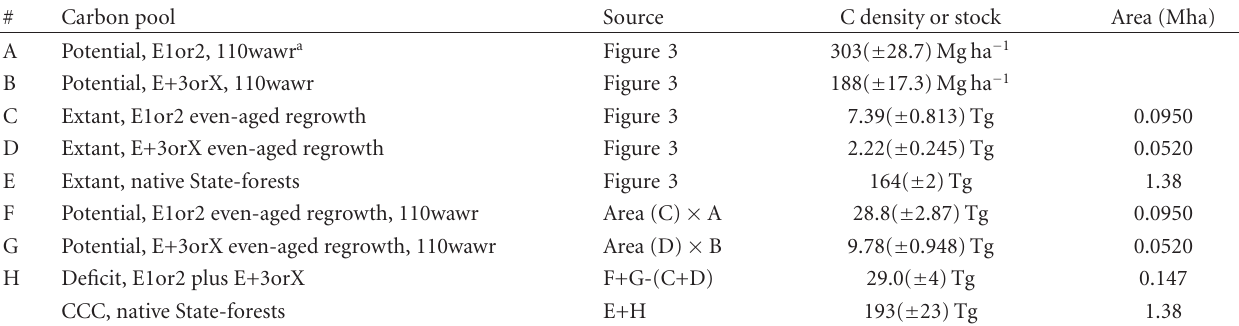
Table 2: Carbon deficit and CCC for State forests based on data in Moroni et al. [1], accounting for wet eucalypt only. Values were rounded to 3 sig. fig. not during calculations but for presentation. a : “110wawr” = age ≥ 110 yrs, with and without